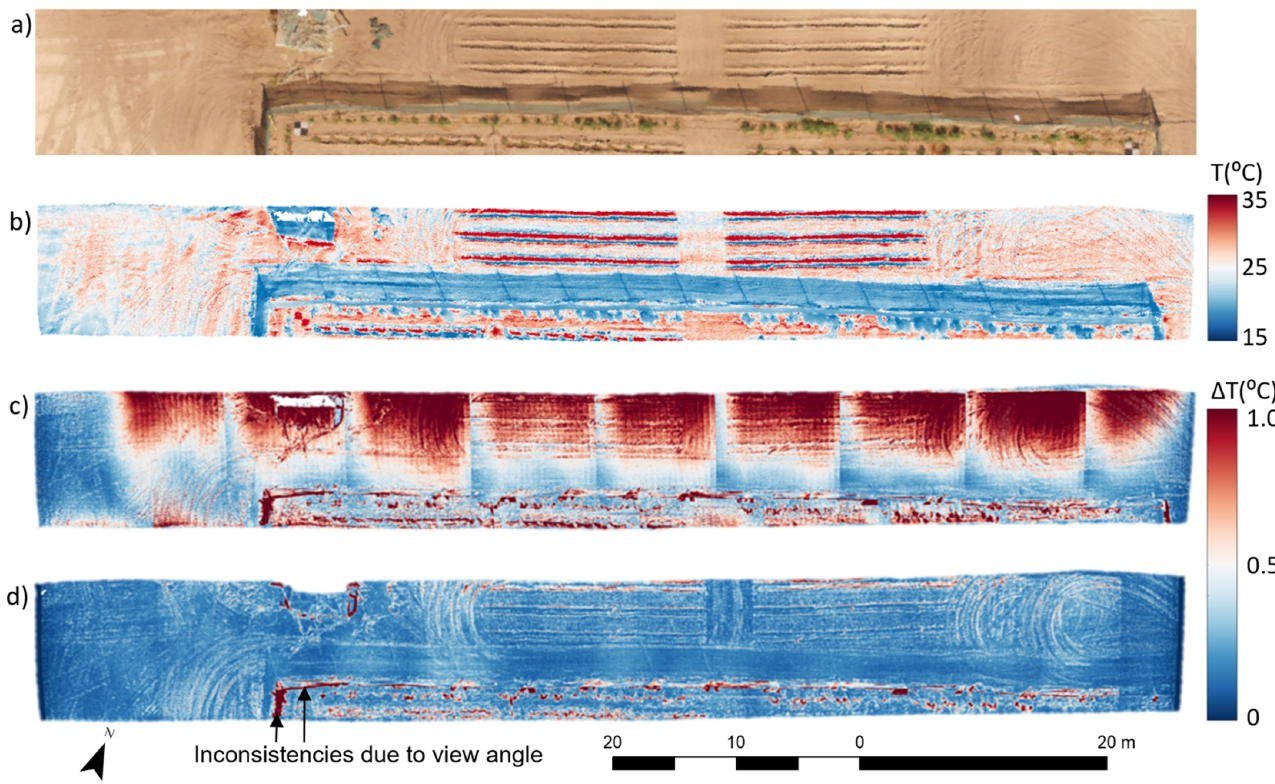
Figure 4. ( a ) RGB image data, ( b ) temperature map derived from the TeAx image data, and the standard deviation of the orthophotos of a swath (i.e., a flight line) before ( c ) and after ( d ) calibration and vignetting correction for 20 December 2017 at 10:00.